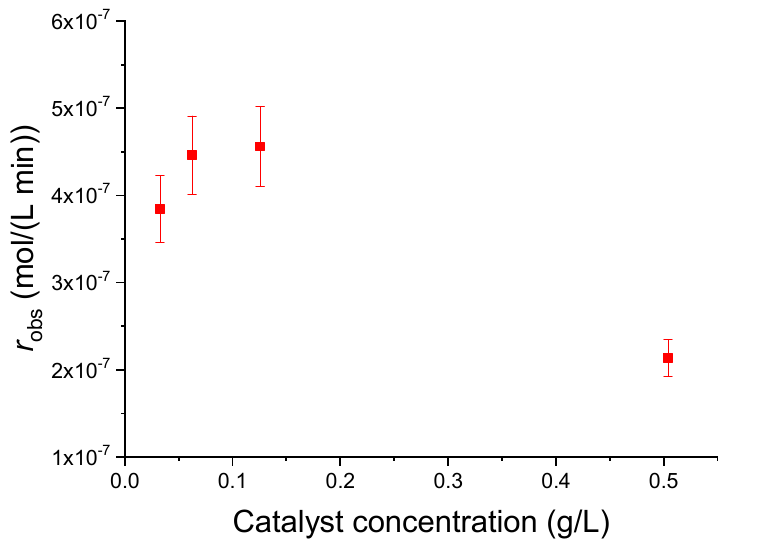
Figure 6. E ff ect of the catalyst/phenol mass ratio on the reaction rate, fi xing T = 40 °C and an initial phenol concentration of 25 ppm. Continuous lines represent the linear fi t necessary to calculate the observed reaction rate ( r obs ).